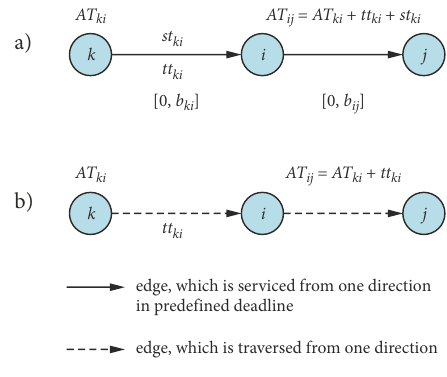
Figure 2. Graphic representation of arrival time in arc routing